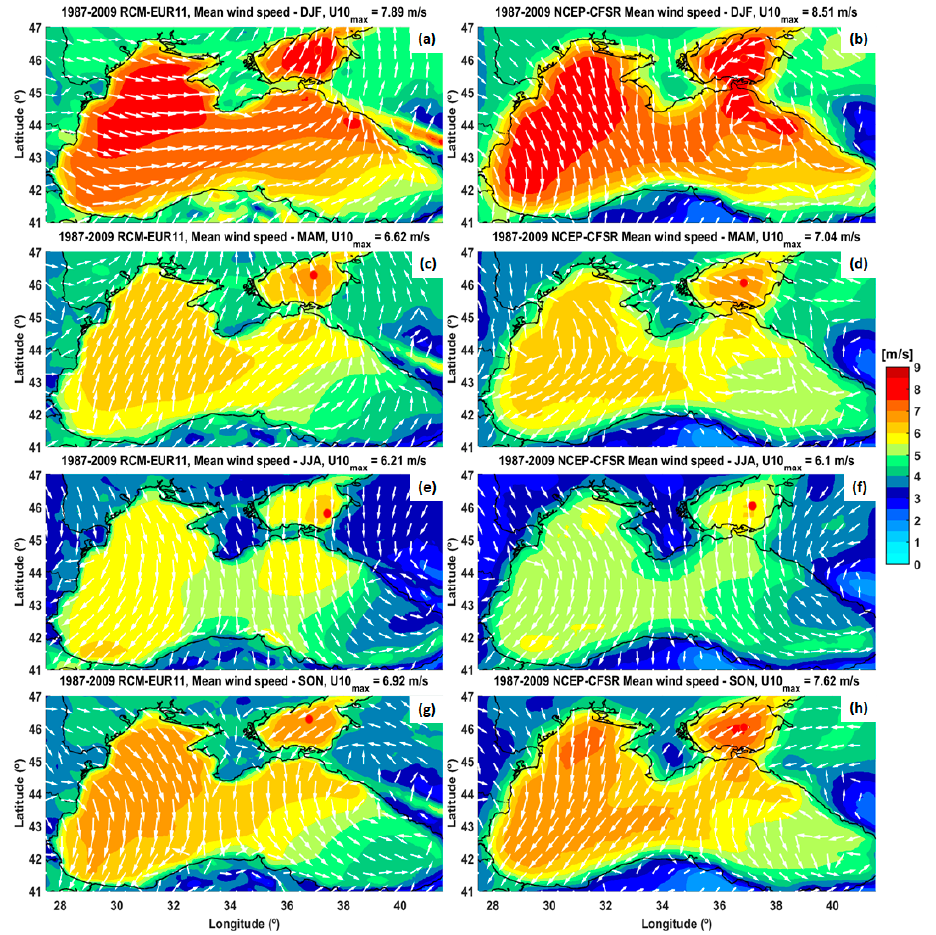
Figure 3. The seasonal averaged wind speed is represented in the background, while the wind vectors indicate the seasonal average wind direction over the time interval 1987–2009: EUR11 (left panels) and NCEP (right panels). From top to bottom the lines show the following seasons: winter—DJF